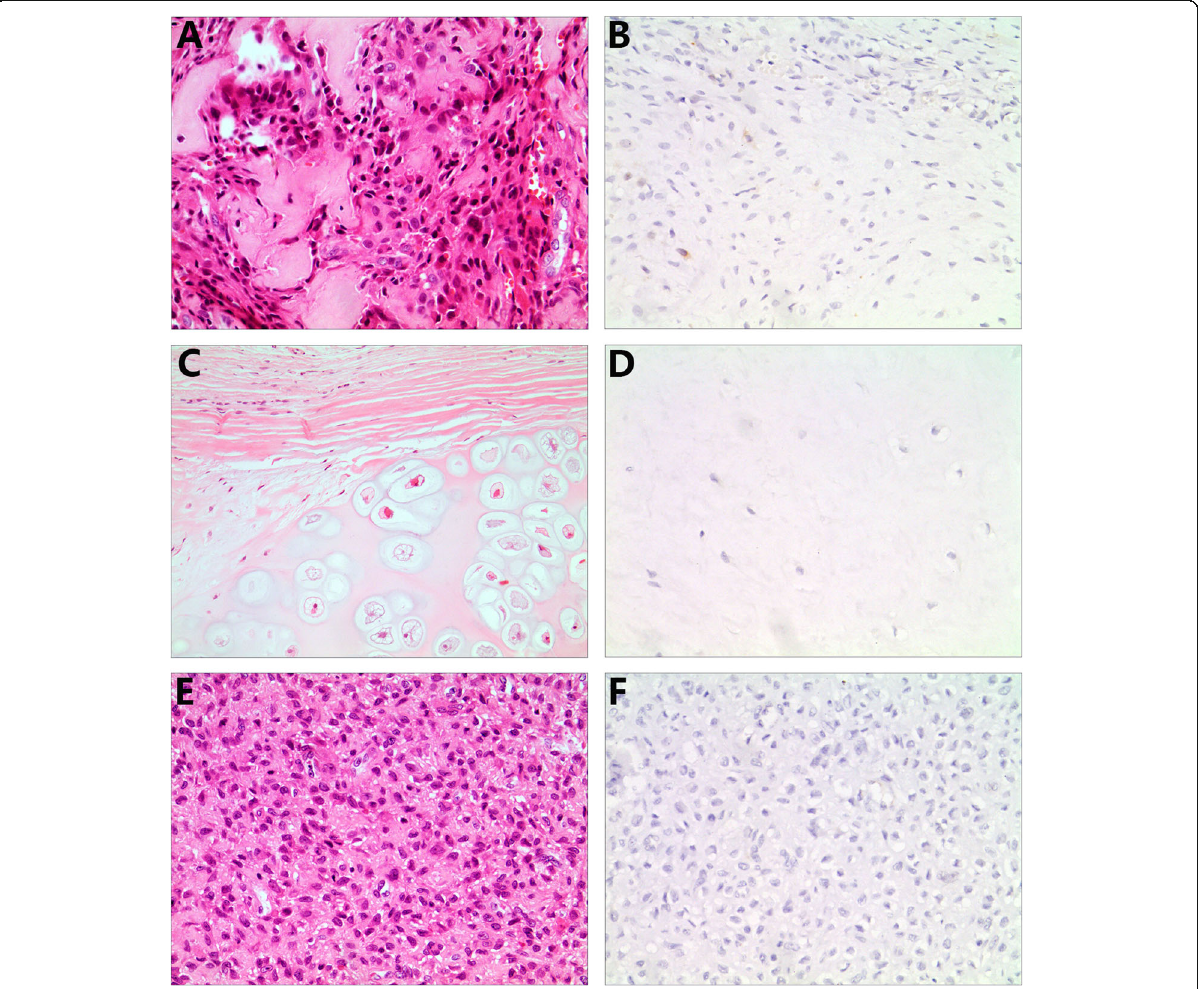
Fig. 2 KPNA2 expression in benign bone tumors. Osteoid osteoma ( a ), osteochondroma ( c ) and chondroblastoma ( e ) samples were negative for KPNA2 ( b , d and f ). ( a – f ×